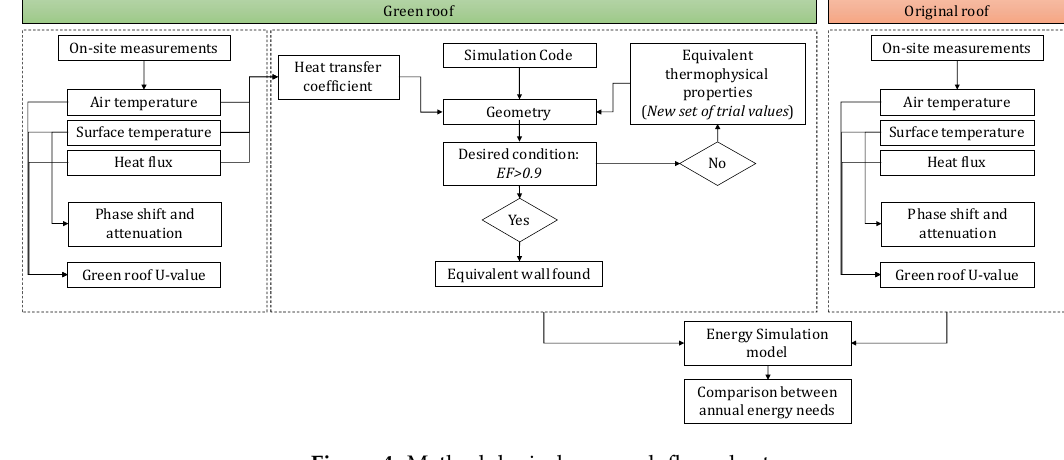
Figure 4. Methodological approach flow-chart.